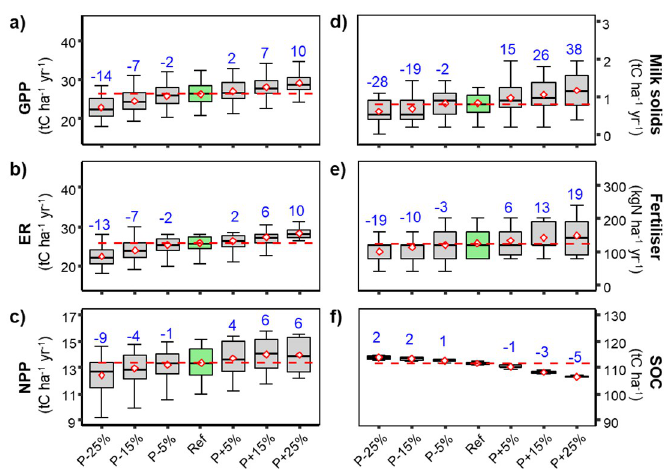
Fig 2. Box and whiskers charts for modelled variables under a range of different amounts of annual precipitation. Details as for Fig 1.